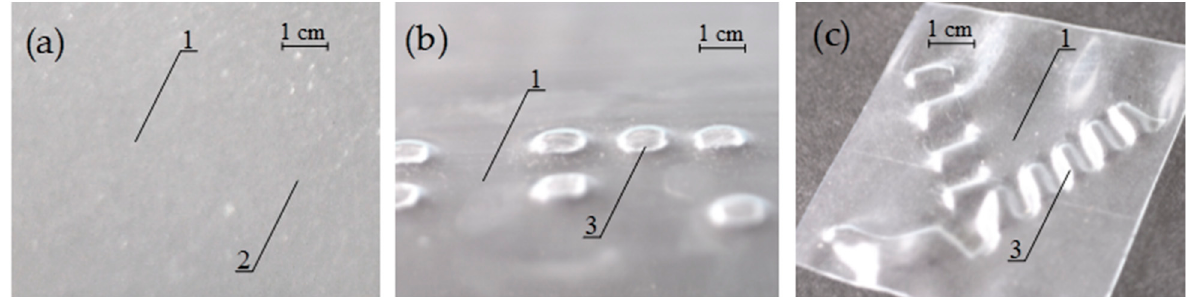
Figure 5. SMP PVC film after local heat treatment under isometric conditions (recording stage) and thermally stimulated free shrinkage (development stage). Tactile relief: ( a ) treated film before shrinking; ( b ) hot stamping; ( c ) laser processing. 1—shrink film, 2—hidden marking, 3—tactile (embossed) marking on the film.